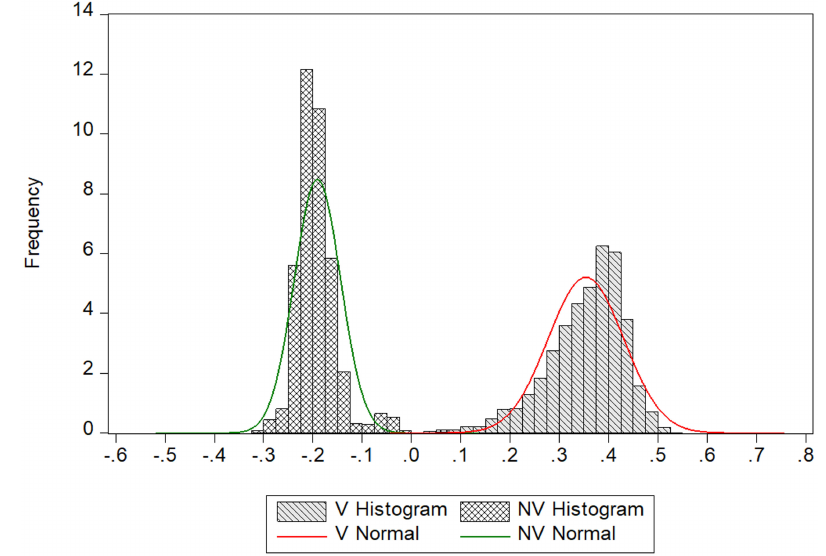
Figure 3. Frequency histogram of vegetation (V) and non-vegetation (NV) in the normalized di ff erence vegetation index (NDVI).